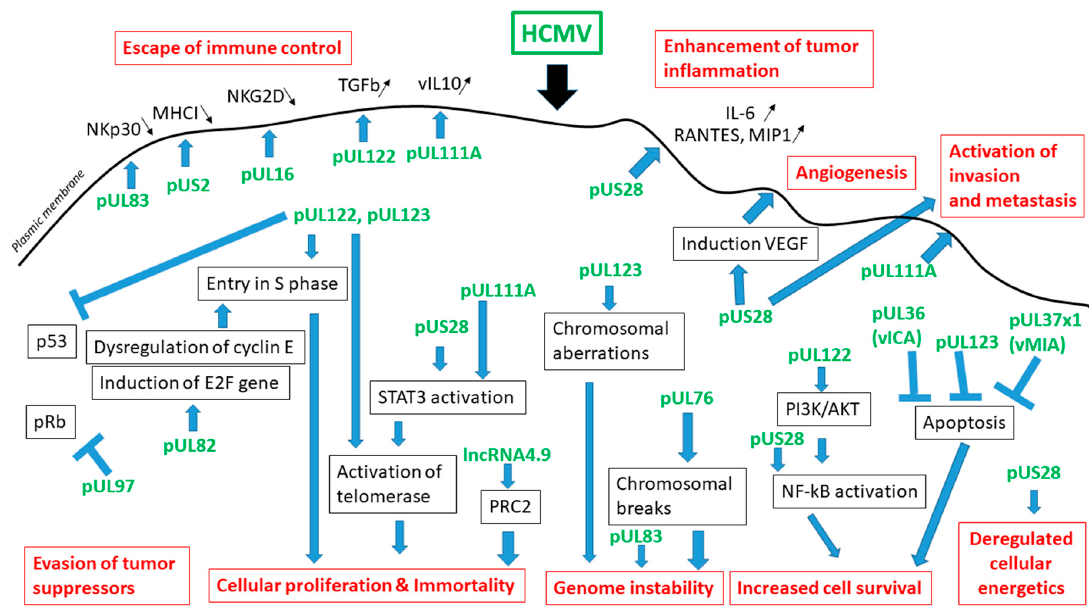
Figure 2. Molecular pro-oncogenic pathways activated by HCMV products. HCMV proteins are in green, cellular effectors in black, and the hallmarks of cancer in red. Black small arrows describe up- or down-regulation of cytokines and cellular proteins.VEGF-Vascular endothelial growth factor; STAT3-Signal transducer and activator of transcription 3; PRC-Polycomb Repressive Complex.